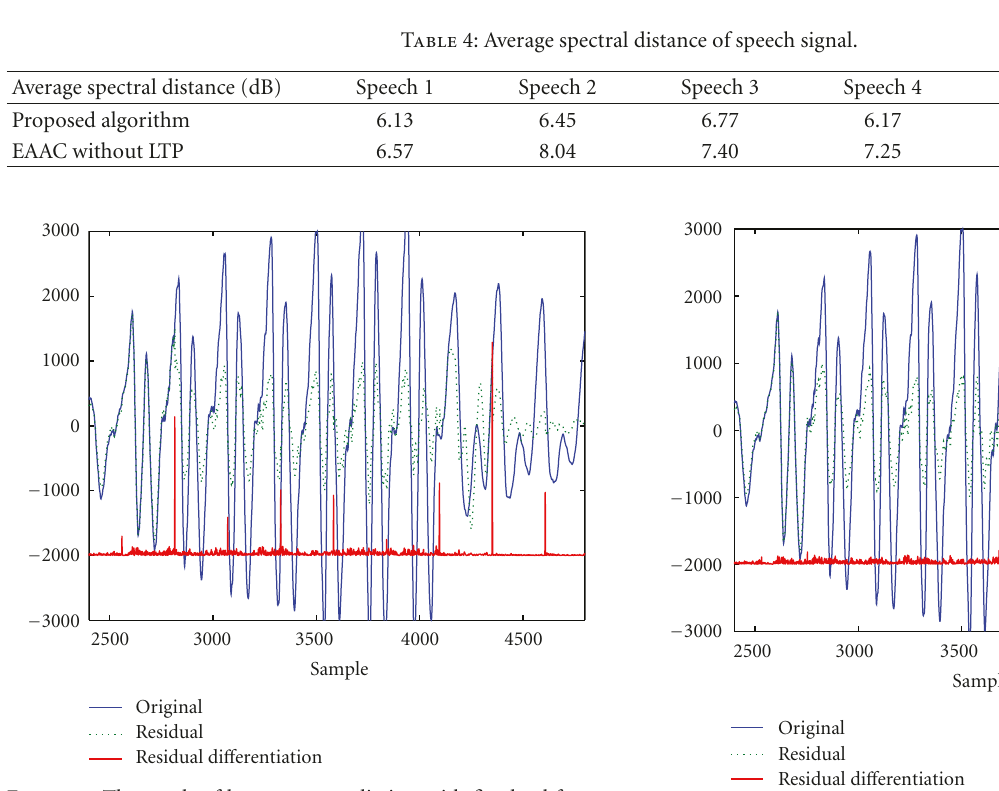
Figure 7: The result of long-term prediction with fixed subframe length. Figure 8: The result of long-term prediction with flexible subframe